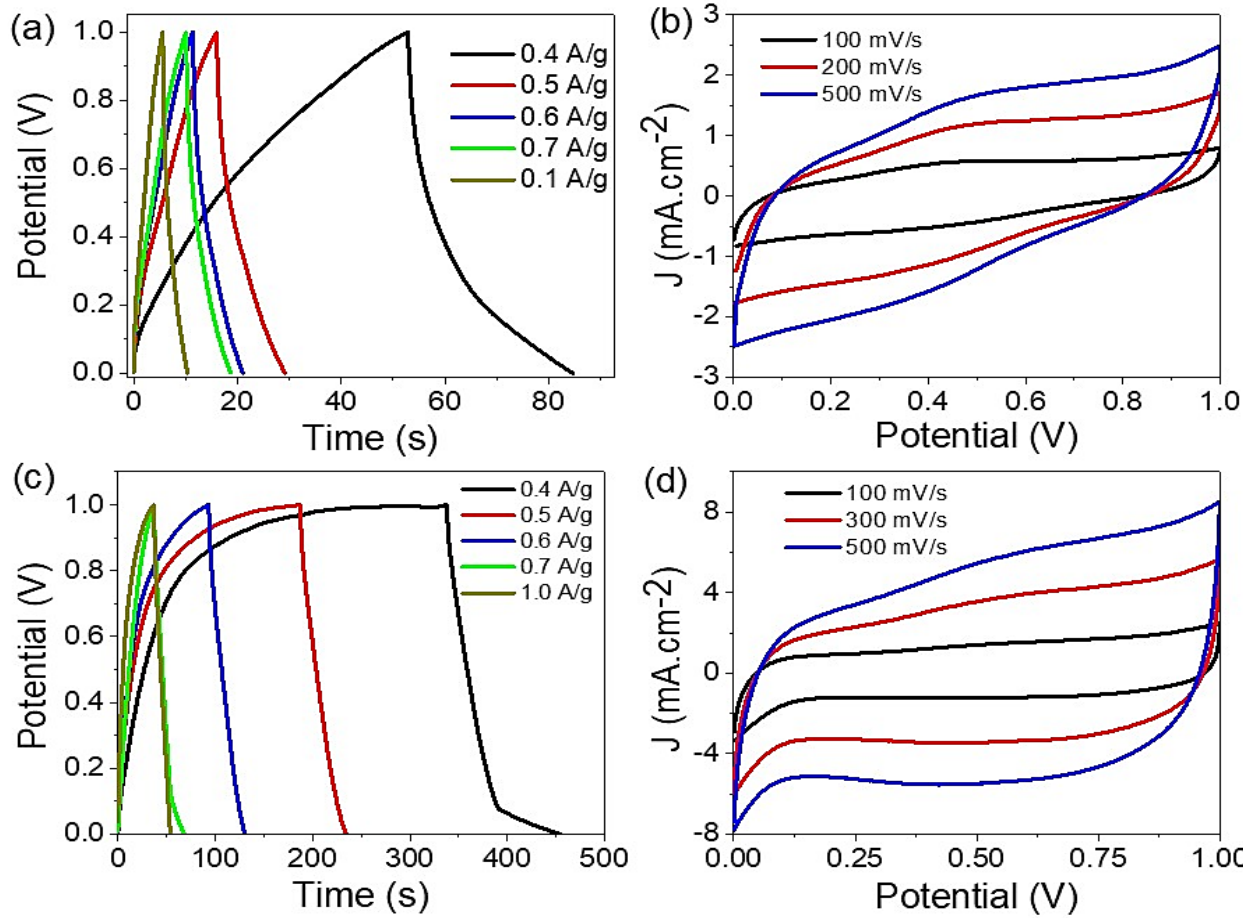
Figure 3. ( a , c ) Charge and discharge and ( b , d ) cyclic voltammetry curves for CoS-Co 2 O 3 /G-C3N4 nanocomposite supercapacitor under HCl and NaOH electrolytes, respectively.